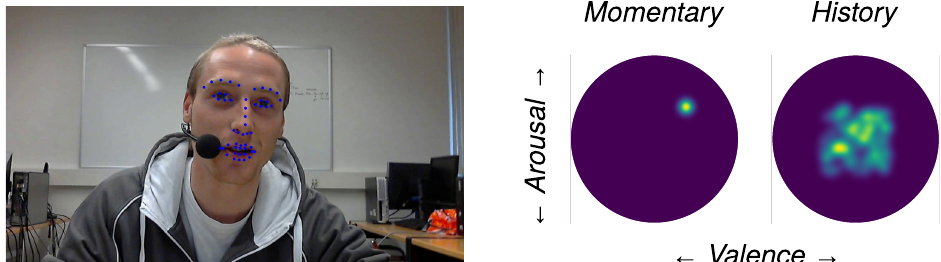
Figure 6. The updated dashboard exploiting the proposed RNN architectures. Firstly, from left to right, we see a frame from the recorded video capturing the speaker, along with the projected facial keypoints predicted from the Facial Landmark Extraction Tool. Then, the estimated momentary values of arousal and valence are projected and illustrated in the Russel’s two-dimensional unit circle. Finally, in a similar way the development of the speaker’s emotional variations are depicted, demonstrating a long-term behavioral pattern during the